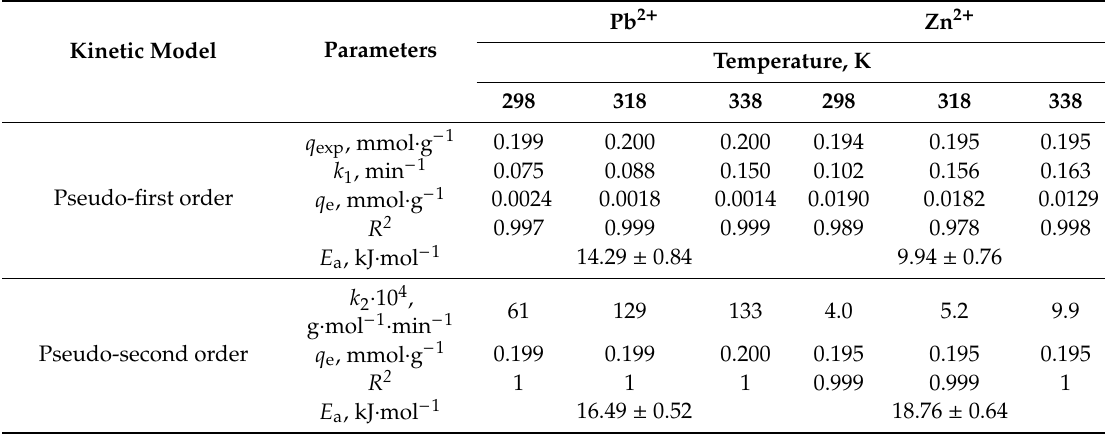
Table 5. Kinetic parameters of pseudo-first-order and pseudo-second-order models for sorption of zinc and lead ions on titanium phosphate (the initial concentration of metal ions was 1 mmol · L − 1